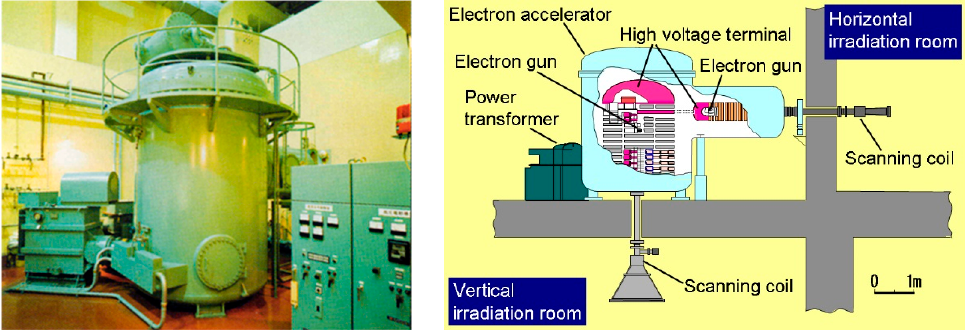
Figure 5. External view of the electron accelerator ( left ) and its internal structure and beam lines ( right ).